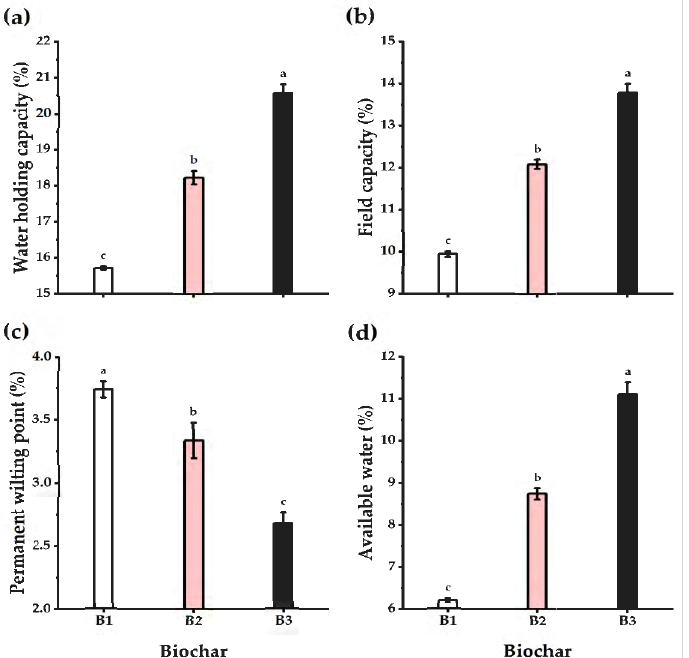
Figure 7. Effect of three levels of biochar soil supplementation (0 (B 1 ), 7.5 (B 2 ), and 15 t ha − 1 (B 3 )) on the physical properties of soil cultivated with wheat at the harvest stage in sandy soil. ( a ) Water holding capacity (%), ( b ) field capacity (%), ( c ) permanent wilting point (%), and ( d ) available water (%). Bars and error bars represent the means ± SE, respectively, of three biological replicates. Different letters reveal statistically significant differences among